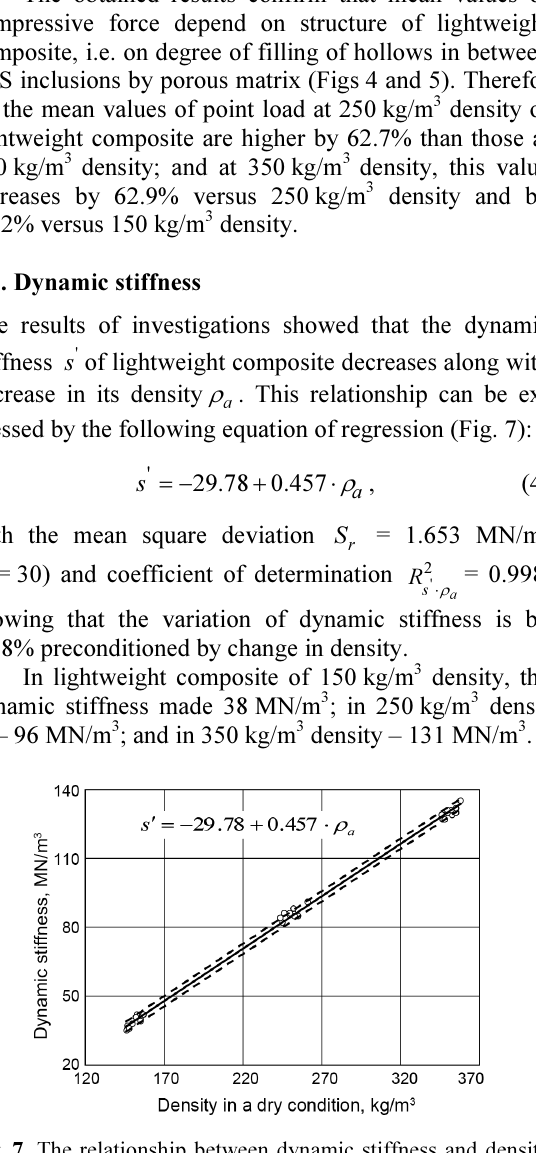
Fig. 7. The relationship between dynamic stiffness and density of lightweight composite: ○ – experimental data; (——) – regression line; (- - - -) – projected minimal and maximal values